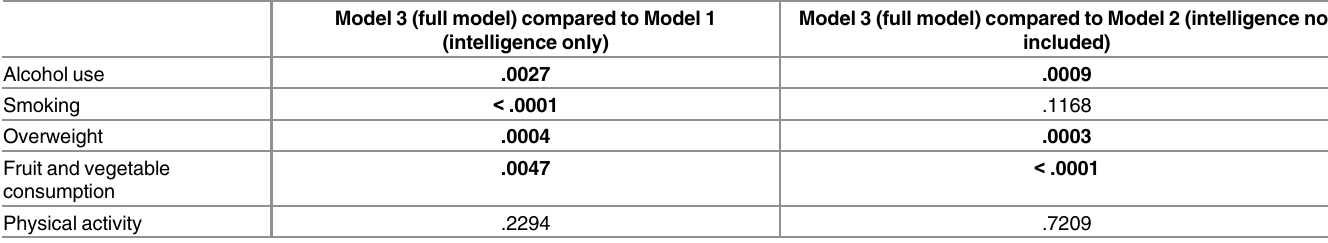
Table 5. Significance level ( p values) of model comparison Wald tests.